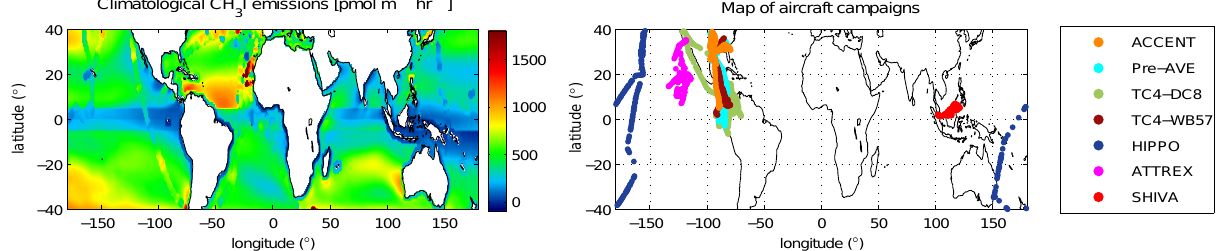
Fig. 6. Climatological CH 3 I emissions [pmolm − 2 h − 1 ] visualized between 40 ◦ S and 40 ◦ N on a 1 ◦ × 1 ◦ grid from Ziska et al. (2013) (a) . Locations of aircraft campaign measurements for the ACCENT, Pre-AVE, TC4, HIPPO2, ATTREX, and SHIVA missions (b) .